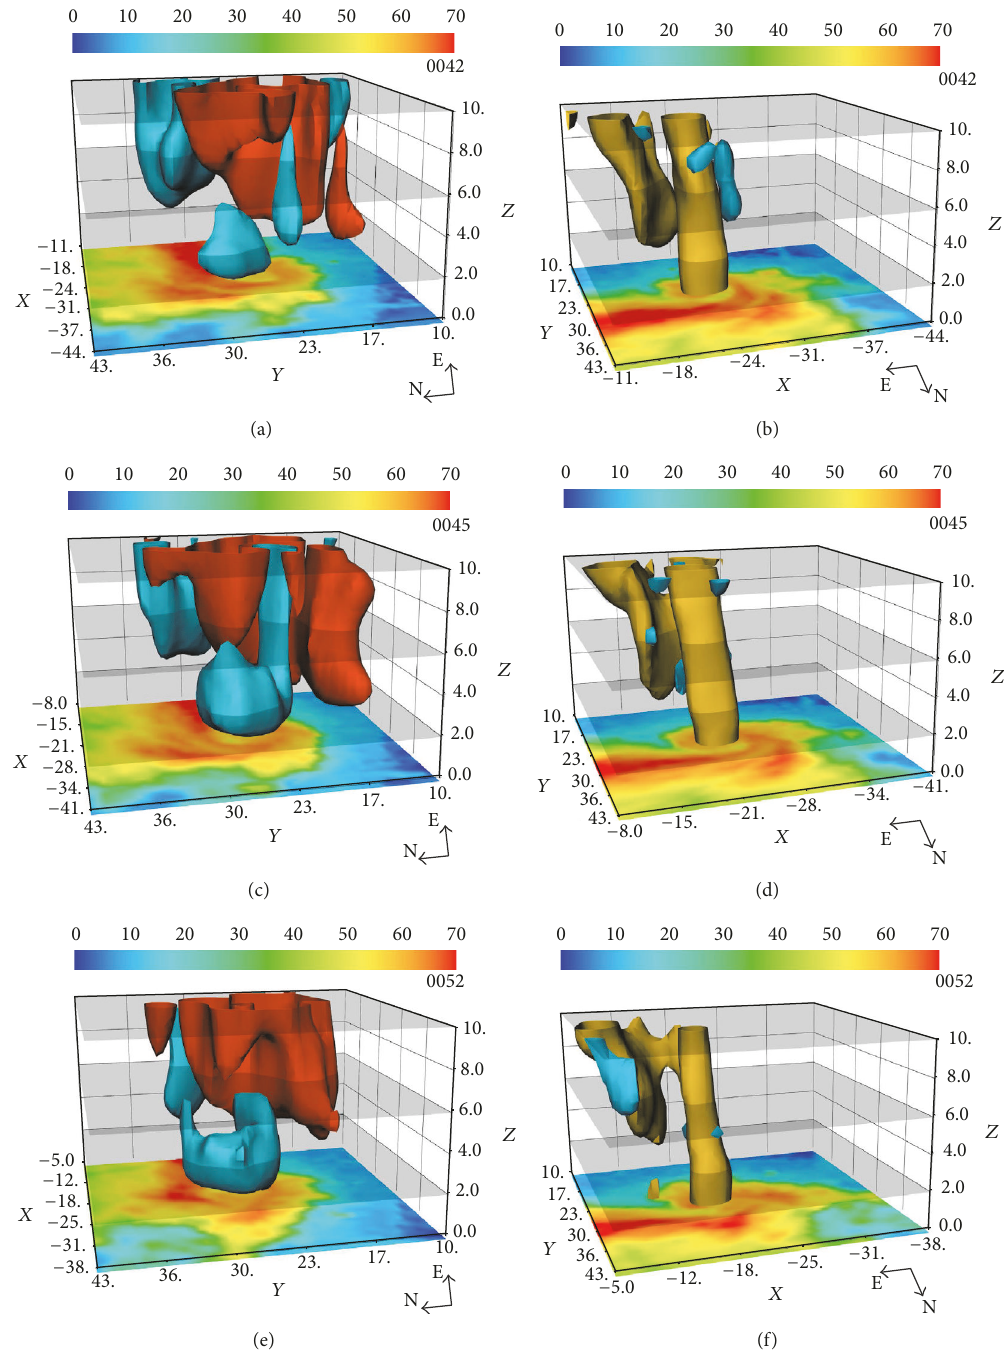
Figure 8: Same as Figure 4, except for during the occlusion stage.